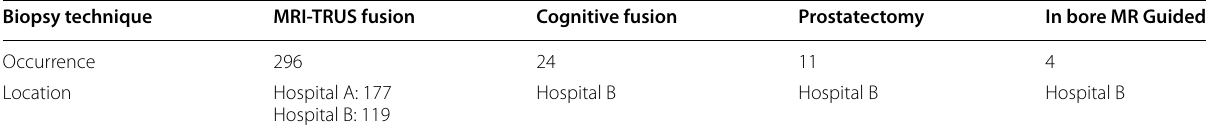
Only hospitals A and B are represented in the biopsy distribution since the 7 other centers are referring institutions which do not perform biopsies. Instead, patients receive MRI scans in one of these 7 centers and are then referred to hospitals A or B for MRI-TRUS fusion if needed